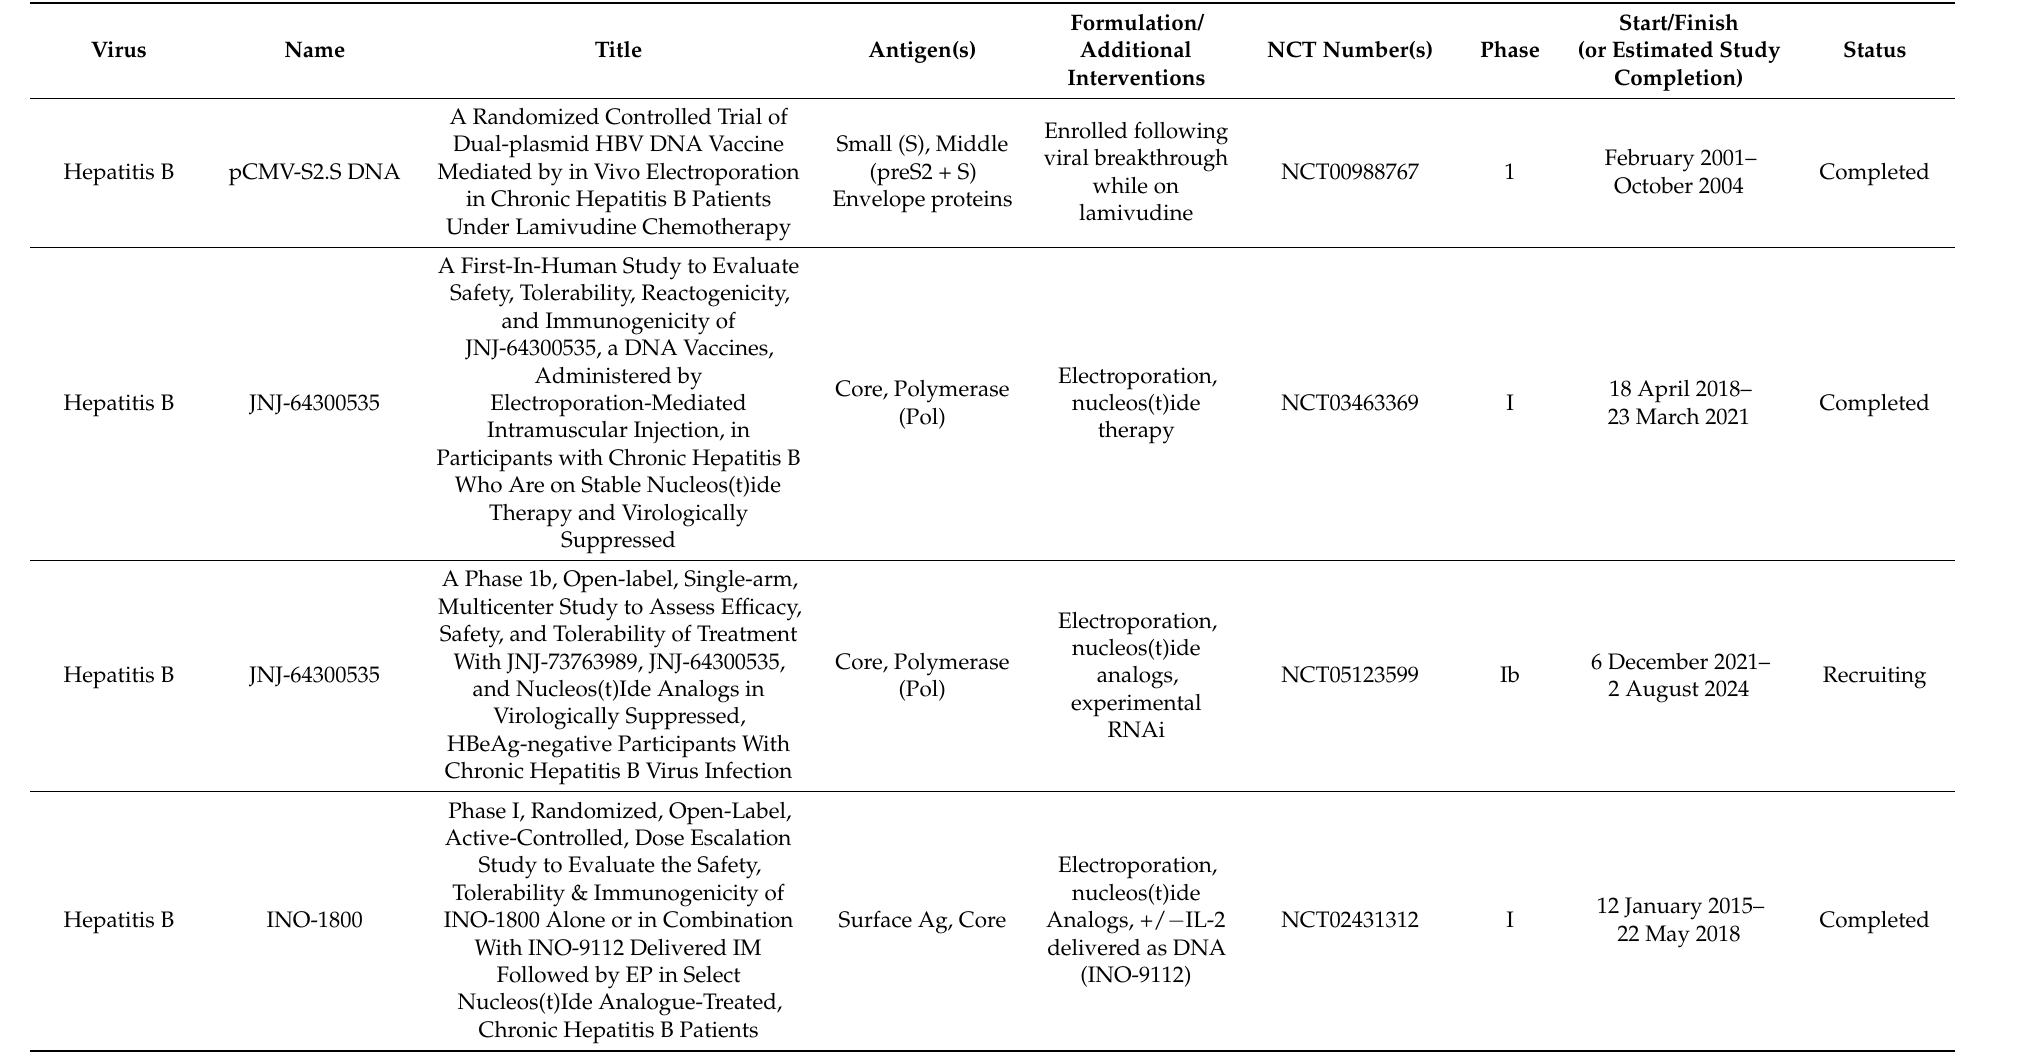
Table 6. Clinical trials for DNA vaccines for chronic viral